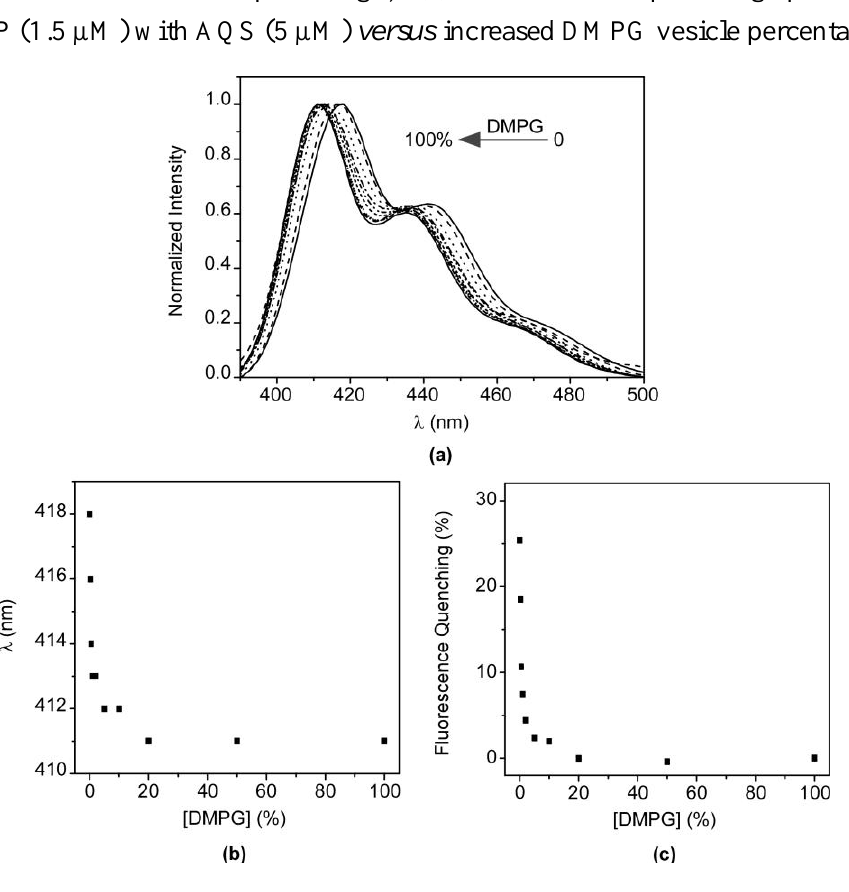
Figure 8. ( a ) Normalized fluorescence emission spectra of HTMA-PFP (1.5 µM) in a mixture of DMPC and DMPG LUVs (final lipid concentration 1 mM) recorded at increasing anionic vesicle content; ( b ) position of the fluorescence maximum as a function of increased DMPG vesicle percentage; ( c ) fluorescence quenching percentage of